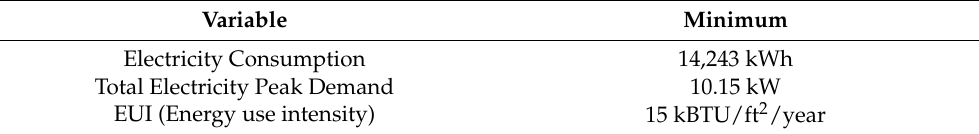
Figure 6. Annual energy use (case study building). Table 6. Summarized annual energy use for the building.